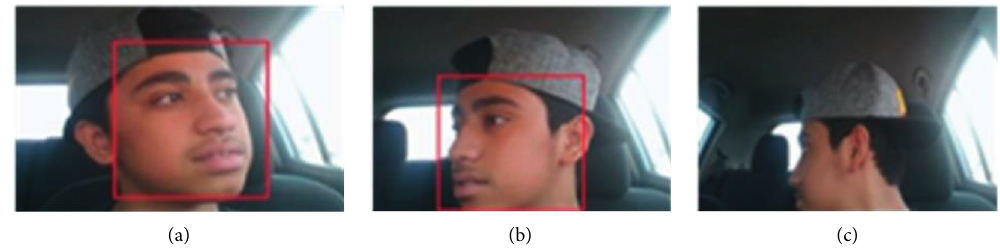
Figure 5: Face tracking. (a) Face detected in 30 ° . (b) Face detected in 45 ° . (c) Face undetected.